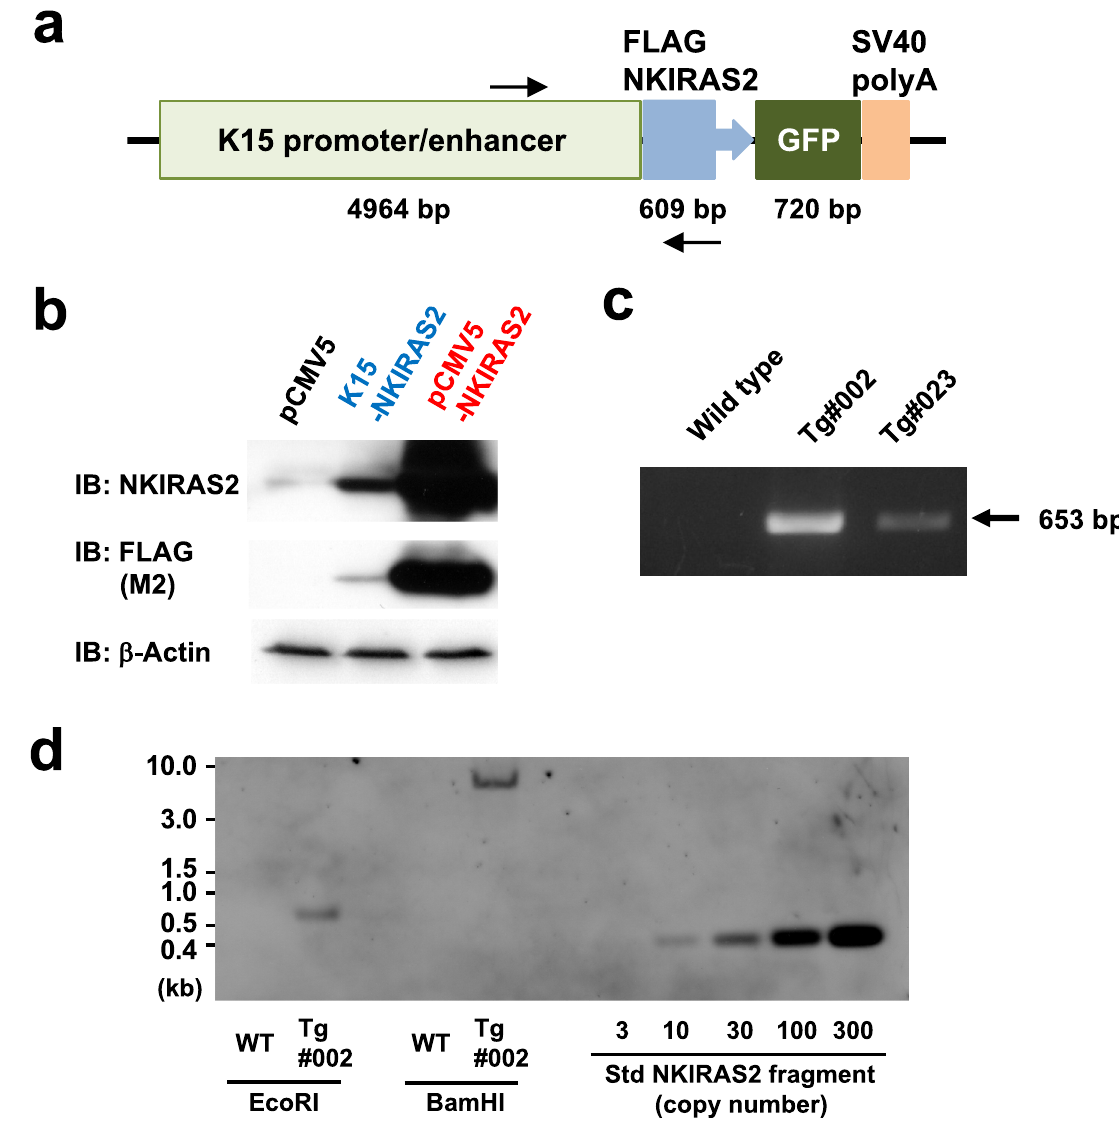
Figure 1. Development of NKIRAS2 transgenic mice. ( a ) The structure of the transgene for expressing NKIRAS2 using the K15 promoter is shown. GFP is the landmark for inserted transgene; however, the protein is not expressed. The arrows indicate the position of designed primers to detect the NKIRAS2 transgene. ( b ) Using HEK293T cells, the expression of NKIRAS2 from the constructed NKIRAS2 transgene was confirmed by immunoblotting. As negative and positive control, pCMV5 and pCMV5-NKIRAS2 was utilized, respectively. ( c ) Using two lines of developed transgenic mice, #002 and #023, the presence of the transgene for NKIRAS2 was confirmed by PCR using genomic DNA samples from wild type and transgenic mice as templates. ( d ) To determine the copy number of NKIRAS2 transgene, southern blot analysis was performed. Blot for transgenic mice #023 was shown in Supplementary Fig.